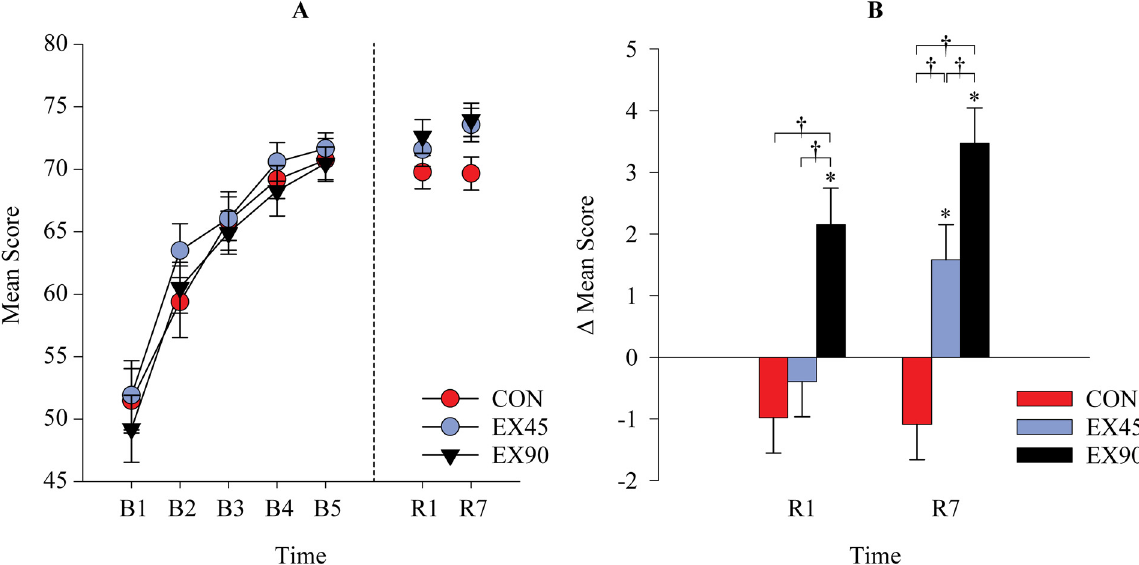
Fig 4. Performance scores in the visuomotor accuracy tracking task (VAT). A : Mean scores ( ± SEM) in the VAT at acquisition Baseline (B1), B2-4 and B5. B: Changes in mean scores ( ± SEM) for all groups in the VAT from Block 5 (B5) to 1d retention test (R1) and 7d retention test (R7). * Significant change from B5 (p = 0.004). † Significant between-group difference (p <